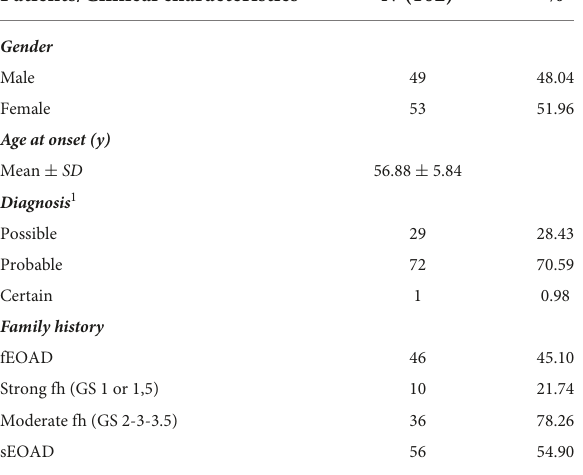
TABLE 1 Clinical features of study